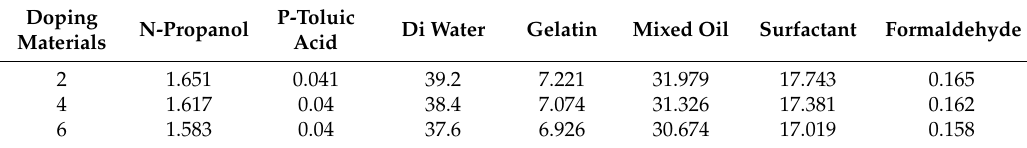
Table 1. Weight percentages of the each component material of the presented tissue-mimicking phantom. (Unit: wt